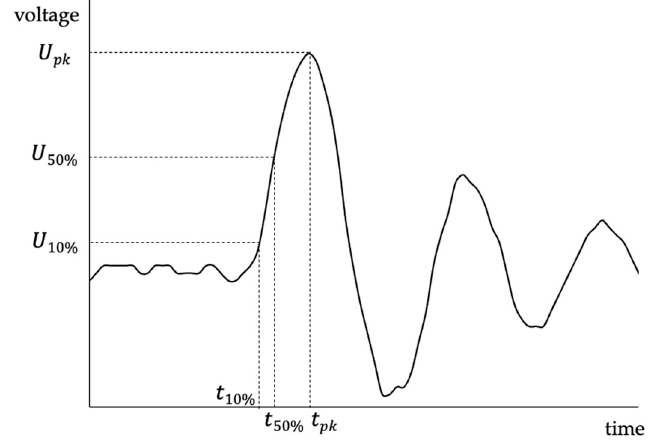
Figure 1. Peak, 50% threshold and 10% threshold values of a PD detector response and their corresponding time instants.